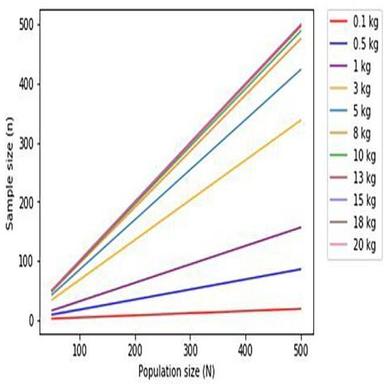
As the population size increases, the sample size also increases. With a small vessel size, a few samples have to be inspected while with a large vessel size of 20 kg of Pu, nearly the population size is required as the sample size.